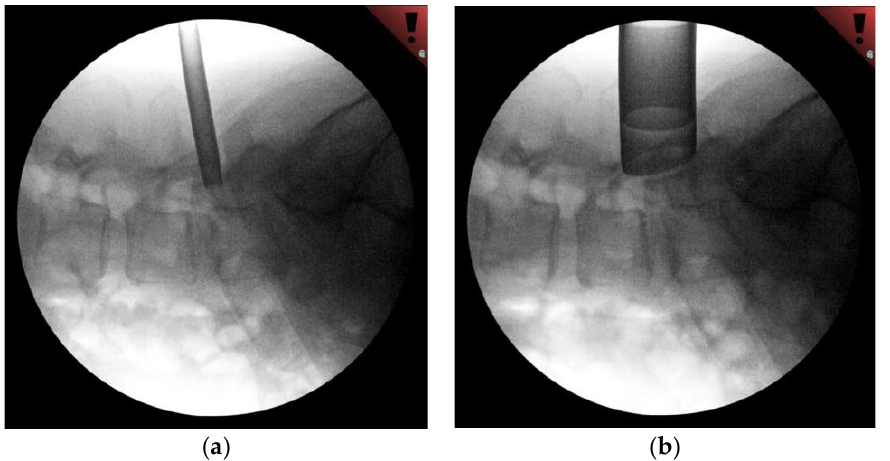
Figure 2. ( a ) Fluoroscopy of initial docking on the caudal TP with the initial dilator. ( b ) Fluoroscopy of the final position of the tubular retractor in line with the disc space, and the caudal TP remaining as the key bony element for docking.